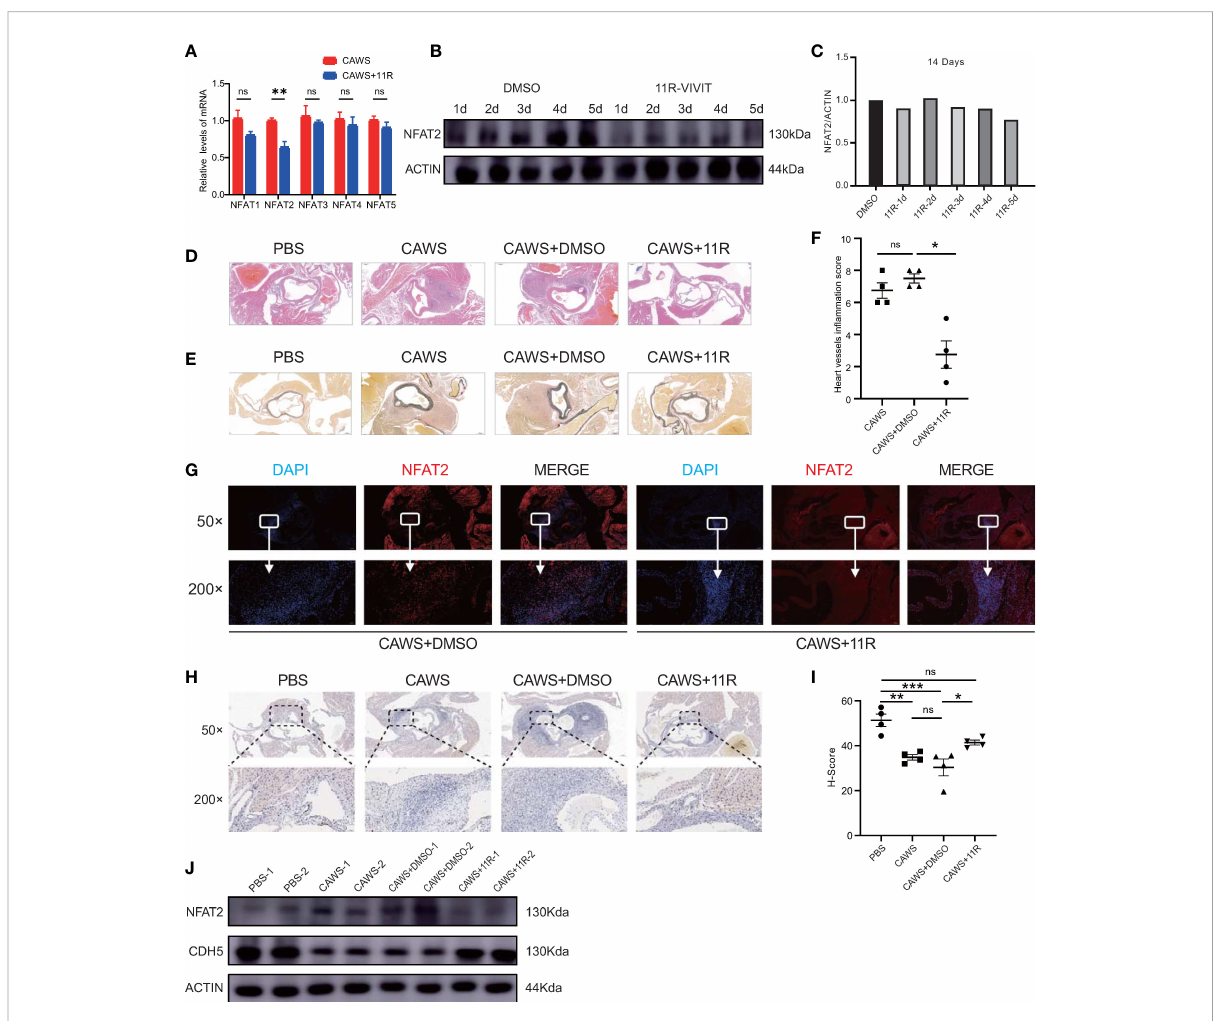
FIGURE 6 11R-VIVIT alleviated CAWS-induced KD vasculitis. (A) qRT-PCR results for NFAT family members in CAWS+11R-VIVIT injected heart tissue (n = 3). (B, C) Immunoblotting analysis of NFAT2 levels in mouse heart tissues from CAWS groups and mouse models injected with an increasing amount of 11R-VIVIT. The loading control comprised b -Actin (B) . NFAT2 levels in different groups quanti fi ed using ImageJ (C) . (D – F) Different groups the mouse were sacri fi ced and heart tissues were harvested, made into sections, and then subjected to hematoxylin and eosin (HE) staining (D) and elastic van Gieson (EVG) staining (F) . Heart vessel in fl ammation scores of WT mice in different groups was analyzed (F) (n = 4). (G) Immuno fl uorescent staining for NFAT2 (red) in heart sections from CAWS+DMSO/CAWS+11R-injected WT mice. All images show DAPI staining of nuclei. (H) immunohistochemical staining for CDH5 in heart sections from different groups. (I) CDH5 protein levels quanti fi ed by the H-score (n = 4). (J) Western blotting assessment of NFAT2 and CDH5 levels in different groups. The loading control comprised b -Actin. Scale bars, 200 µm (50×) and 10 µm (200×). Data are presented as the mean ± SEM. Quantitative data were analyzed using Kruskal – Wallis tests (F) and one-way ANOVA (I) , *P < 0.05, **P < 0.01, ***P <